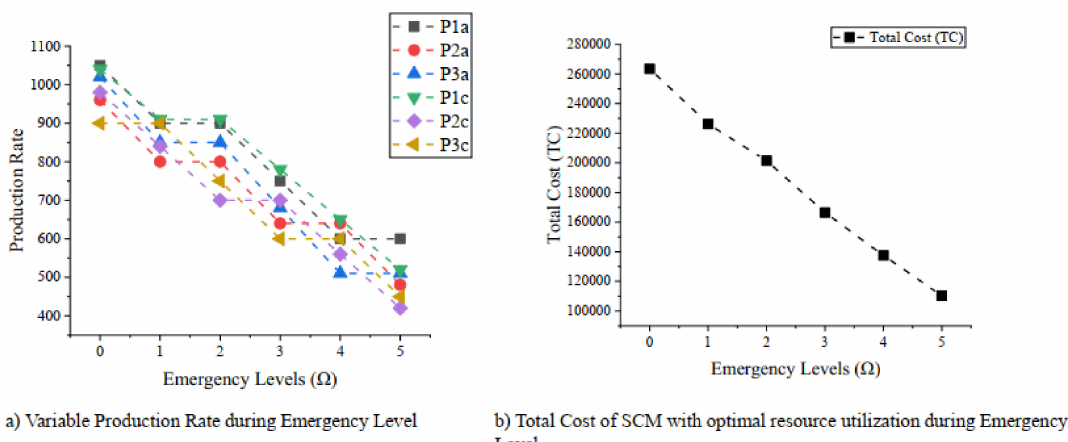
Figure 3. The representation of plant production rate and total cost during emergency: ( a ) is showing the optimal controllable production rate required by manufacturing plant ( b ) is the representation of decreasing total cost of SCM by the proactive approach to cope with variable